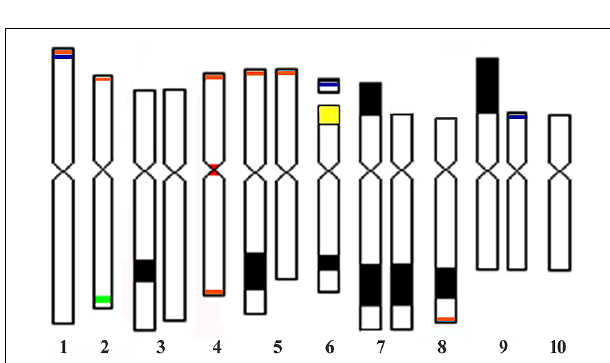
FIGURE 2 | Ideogram representative of the somatic chromosomes of JD lines showing knobs on chromosomes 3, 5, 6, 7, 8, and 9, detected by C-banding and FISH probed with the knob 180-bp repeat (black), small 180-bp repeat signals (blue), subtelomeric 4-12-1 clone (orange), Cent4 (red), 5S rDNA (green), and NOR rDNA (yellow). Knobless homologues of chromosomes 3, 5, 7, (without K7S), and 9 are displayed.